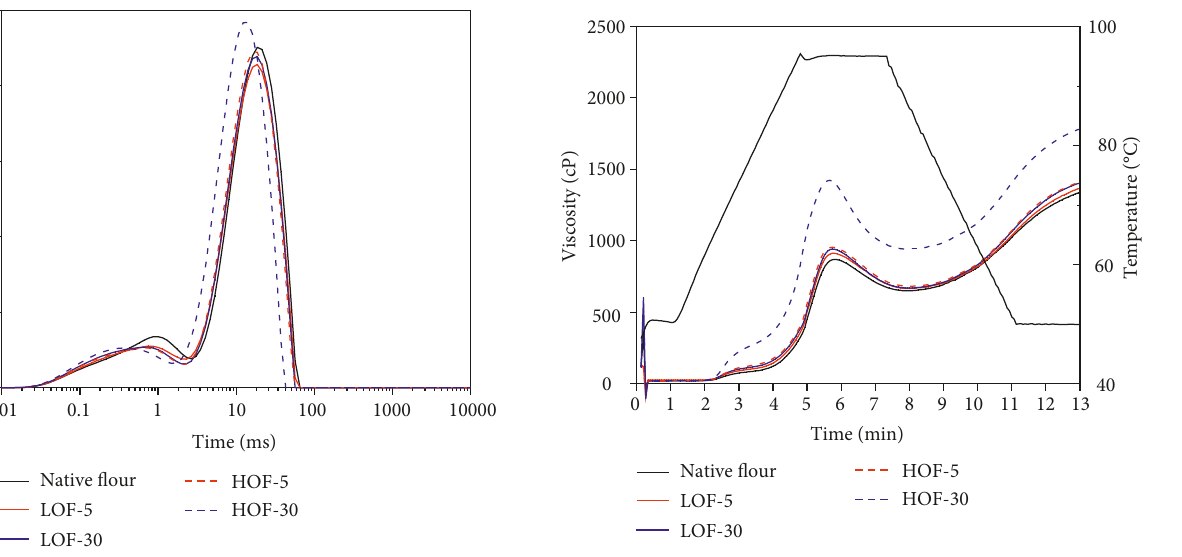
Figure 4: Proton distributions of doughs of native and ozone- treated wheat flours. LOF-5: wheat flour treated at low-intensity condition for 5min; LOF-30: wheat flour treated at low-intensity condition for 30min; HOF-5: wheat flour treated at high-intensity condition for 5min; HOF-30: wheat flour treated at high-intensity condition for 30min.